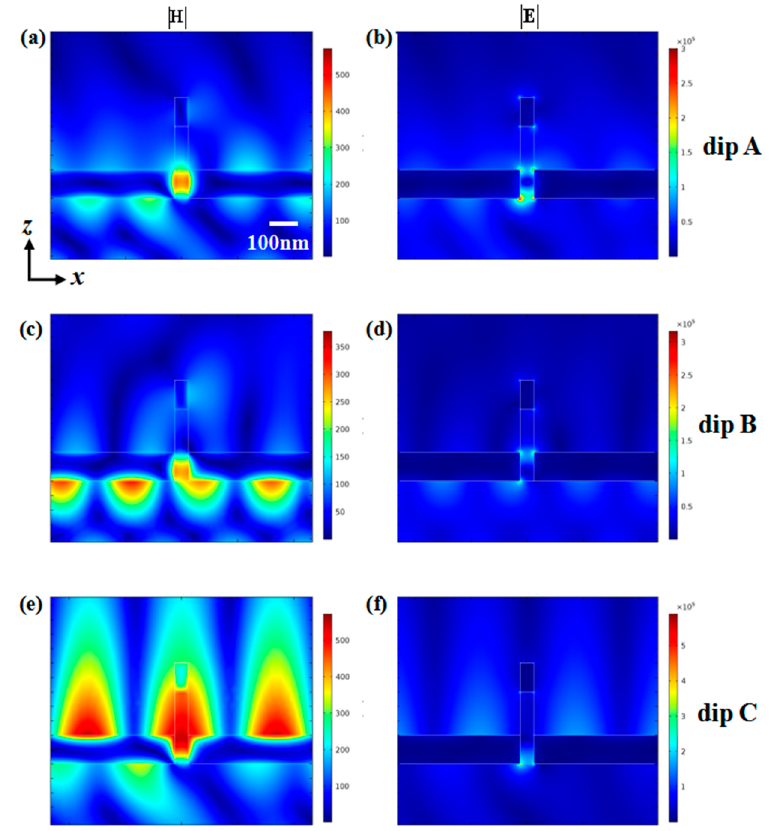
Figure 7. Near-field distribution at resonant dips when the incident angle is 65 ◦ . ( a ) Magnetic field distribution and ( b ) electric field distribution at resonance dip A. ( c ) Magnetic field distribution and ( d ) electric field distribution at resonance dip B. ( e ) Magnetic field distribution and ( f ) electric field distribution at resonance dip C.